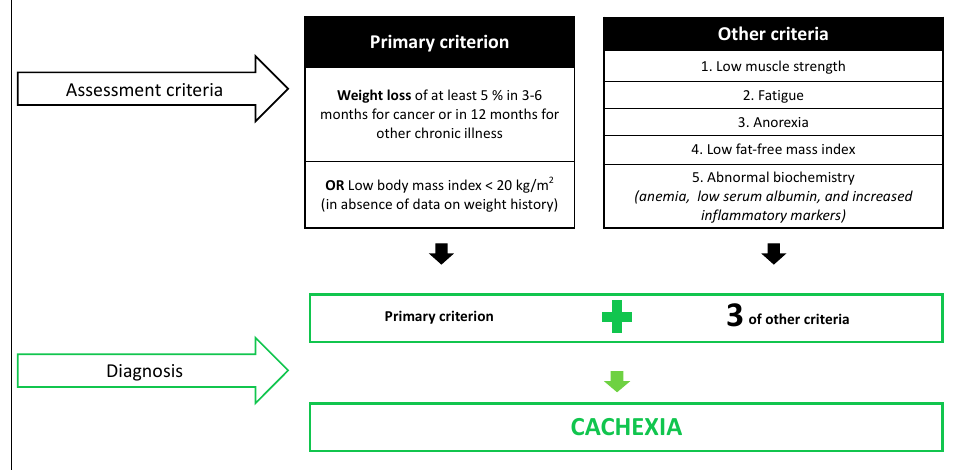
Figure 3. Cachexia diagnostic criteria by Evans et al. [11].